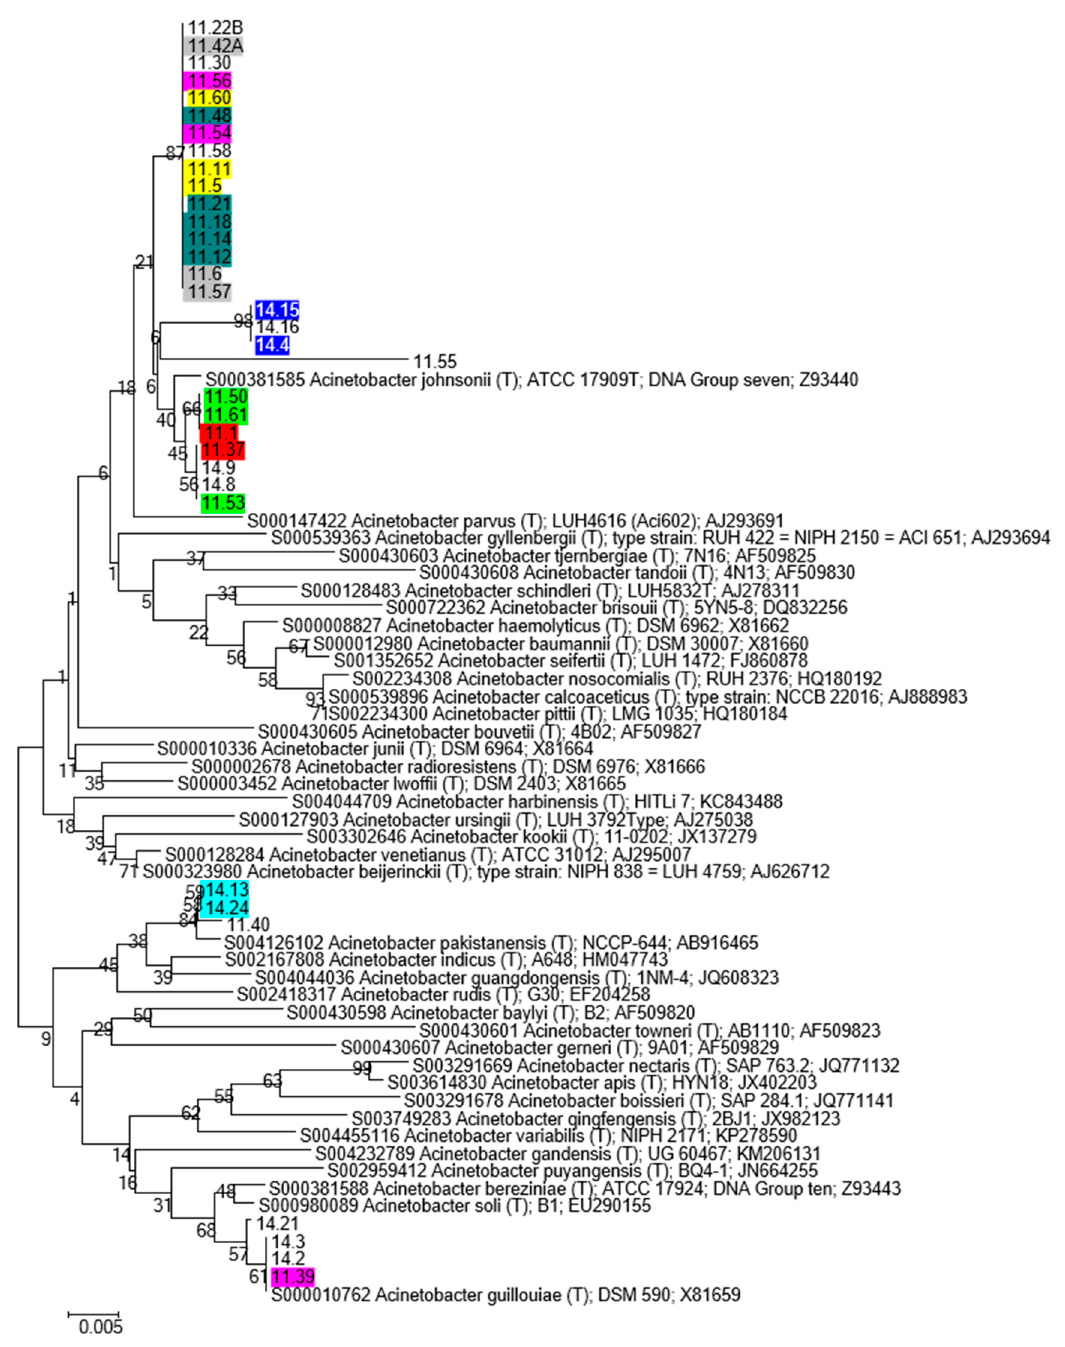
Figure 5. Phylogenetic tree showing relationships between Acinetobacter sp. isolates, and Acinetobacter sp. Type Strains retrieved from RDP database. The tree was constructed based on 16S rRNA gene sequences, with Neighbor-Joining algorithm and 100 bootstrap values. Isolates exhibiting the same RAPD profile are indicated with the same color.